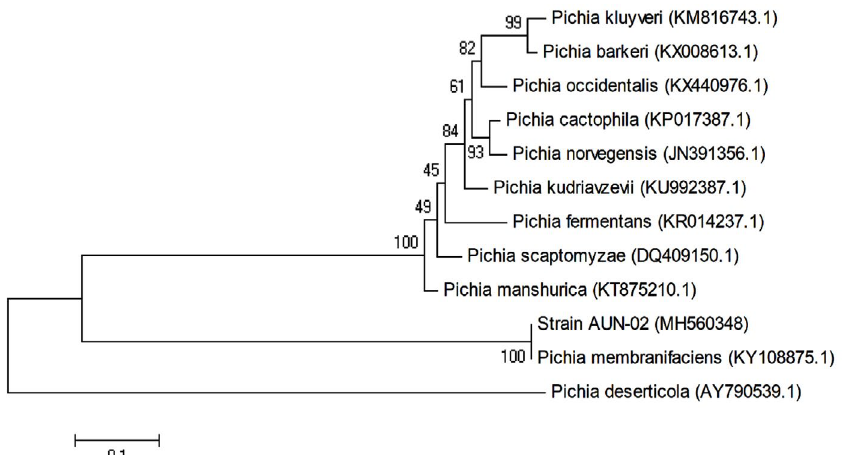
Fig. 1. Phylogenetic relationships between strain AUN-02 and 26S rRNA gene sequences from other published Pichia spp. GenBank accession numbers are given in